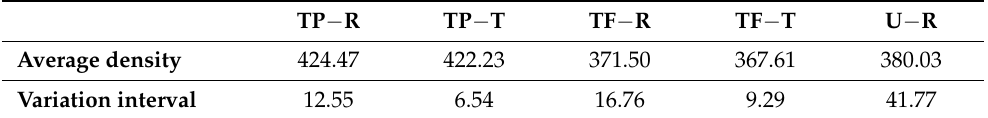
Table 7. Average specimen densities (kg · m − 3